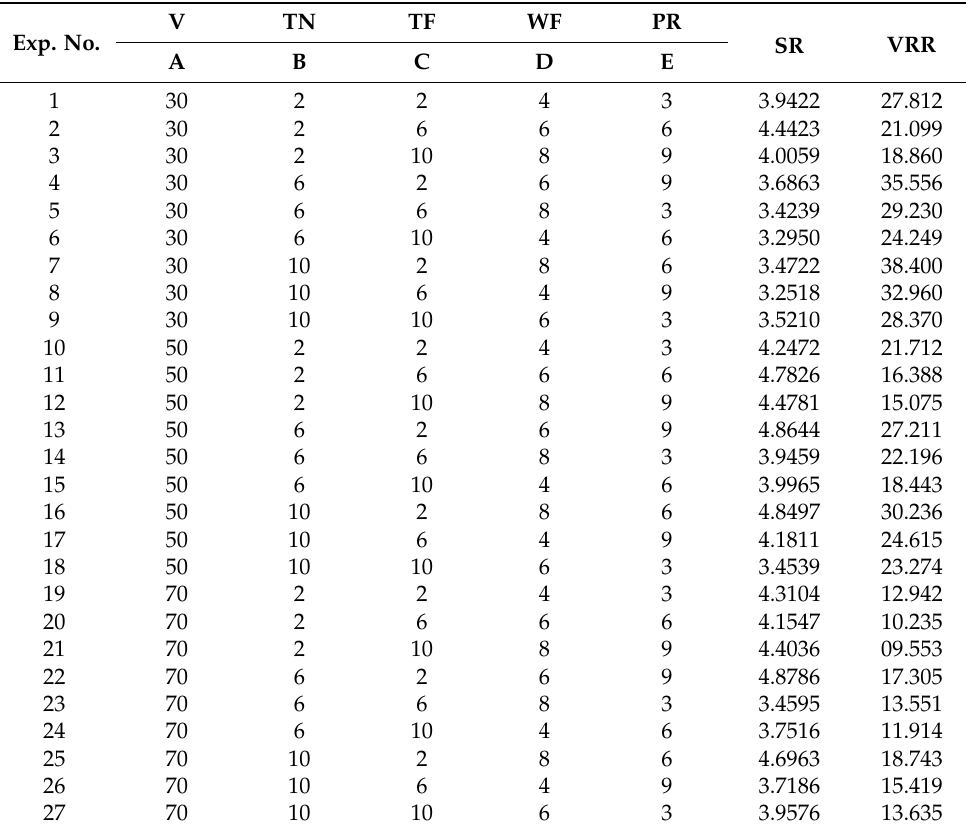
Table 6. Experimental observation and evaluated